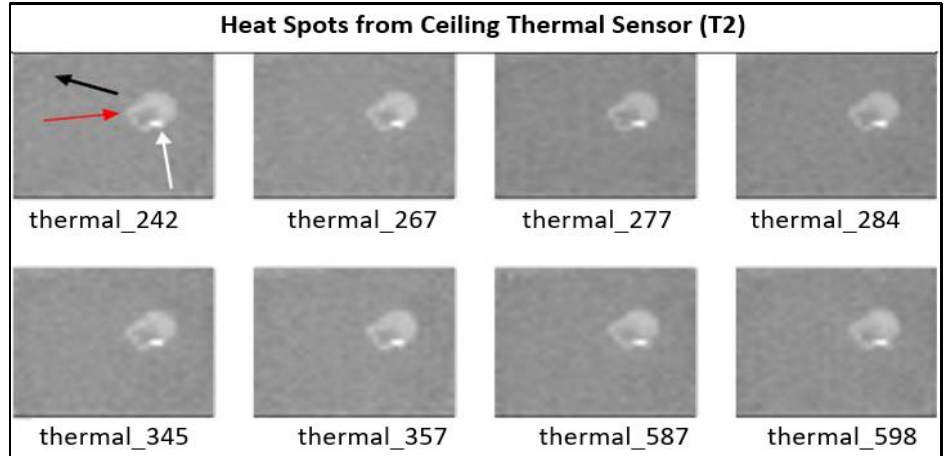
Figure 7. Heat pots from tea/coffee cups occluded from the lateral thermal sensor (T1) but indicated by the ceiling thermal sensor (T2). The black arrow on thermal_242 points to the location of T1, the white arrow points to the heat spot, and the red arrow points to the hand of the participant (occluding the heat spot). Sensor Data Fusion